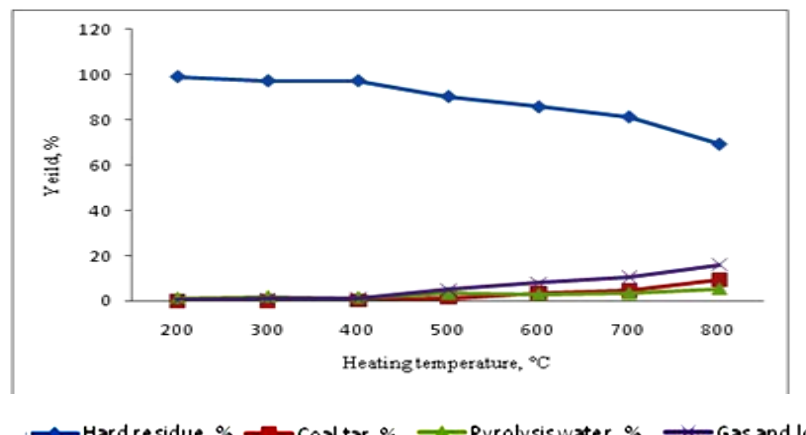
Fig. 8. The yields of pyrolysis products of borehole VIII from Tavan tolgoi coal at different heating temperature